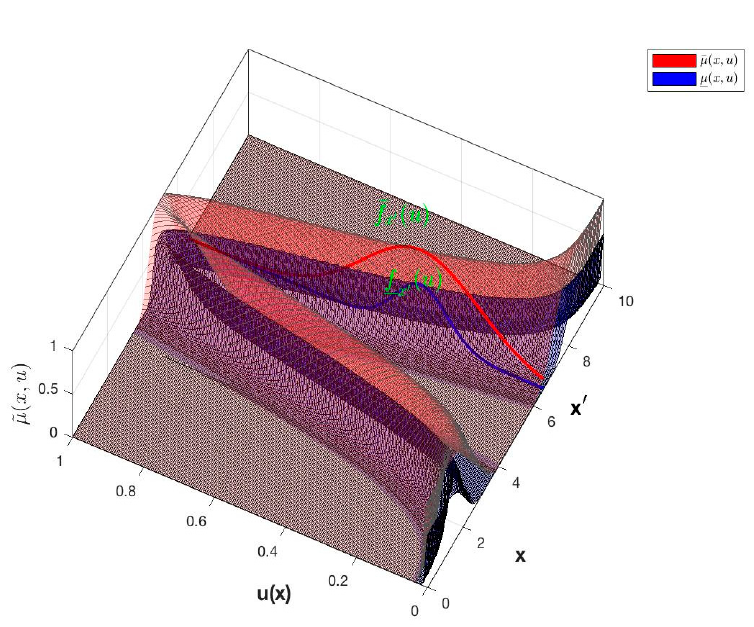
Figure 1. IT3 FS with IT3MF 𝜇(cid:3556)(𝑥, 𝑢) where 𝜇(𝑥, 𝑢) is the LMF and 𝜇(𝑥, 𝑢) is the UMF.